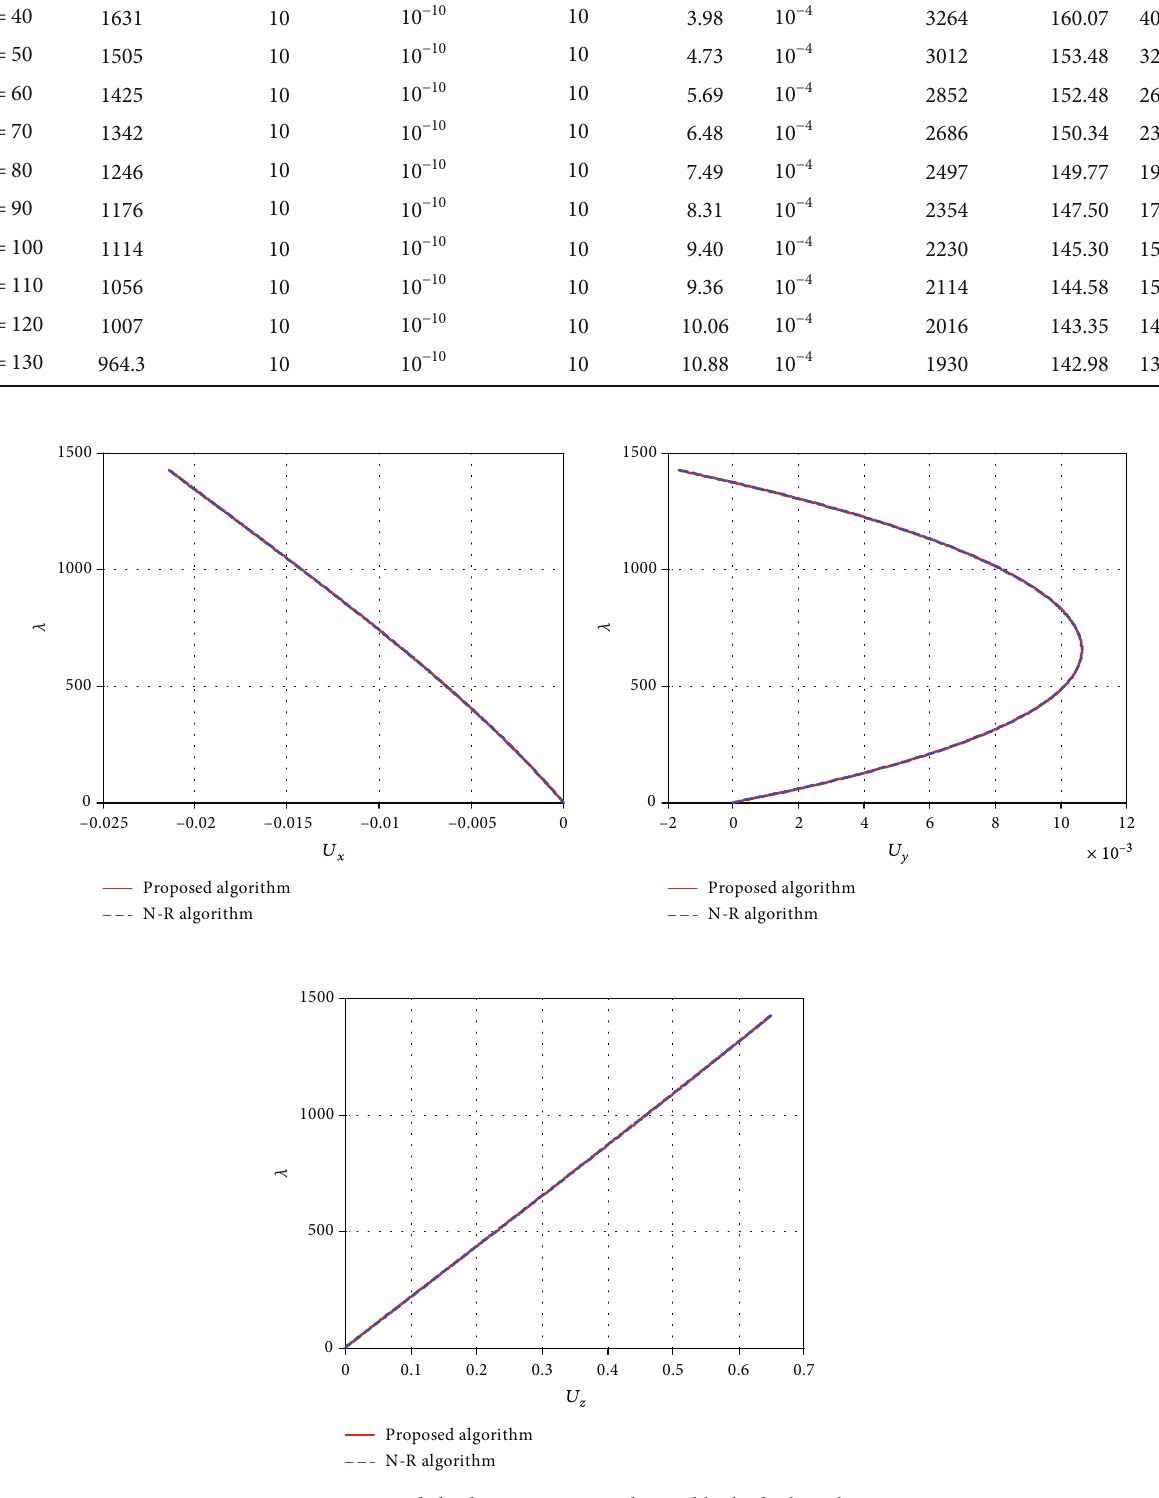
Figure 7: Load-displacement curves obtained by both